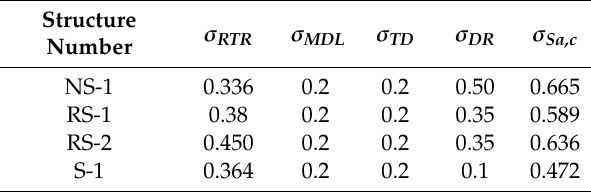
Table 2. Values of various collapse uncertainties.